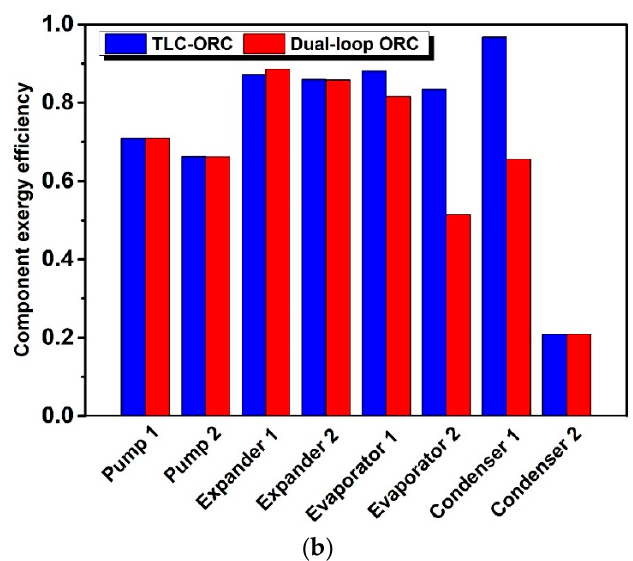
Figure 15. Comparison of exergy destruction and exergy efficiency for each component between the two configurations. ( a ) Comparison of exergy destruction for each component between the two configurations; ( b ) Comparison of exergy efficiency for each component between the two configurations.